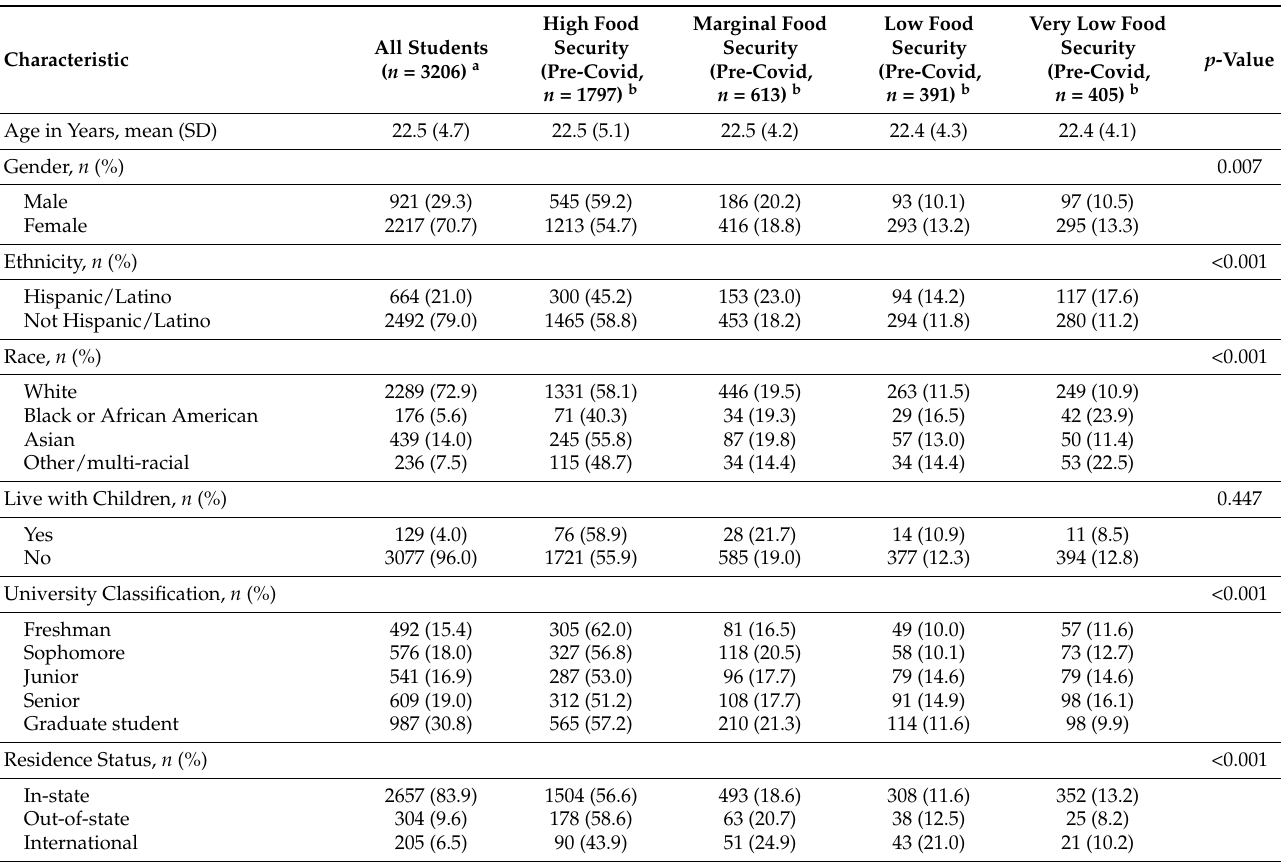
Table 2. Participant Sociodemographic